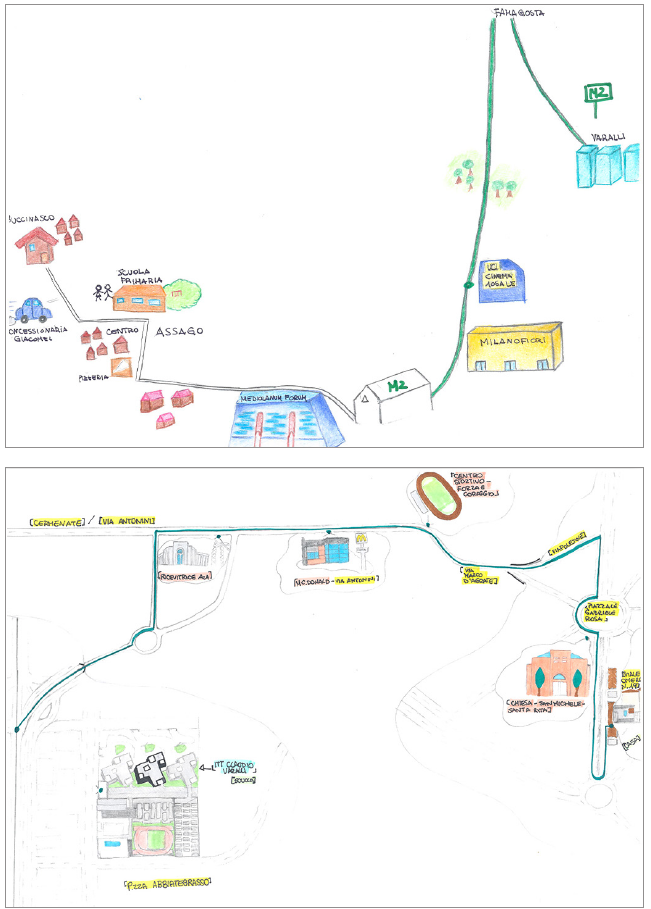
Fig. 3 Two home-school route maps drawn by high-school students during the lectures on landscape and